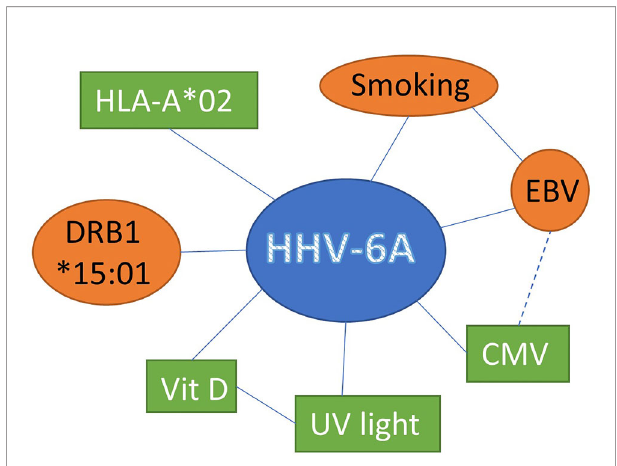
FIGURE 1 | Interaction between HHV-6A and other factors suspected of modulating MS disease susceptibility susceptibility and progression increasing (red circles) or decreasing (green boxes) the risk for MS